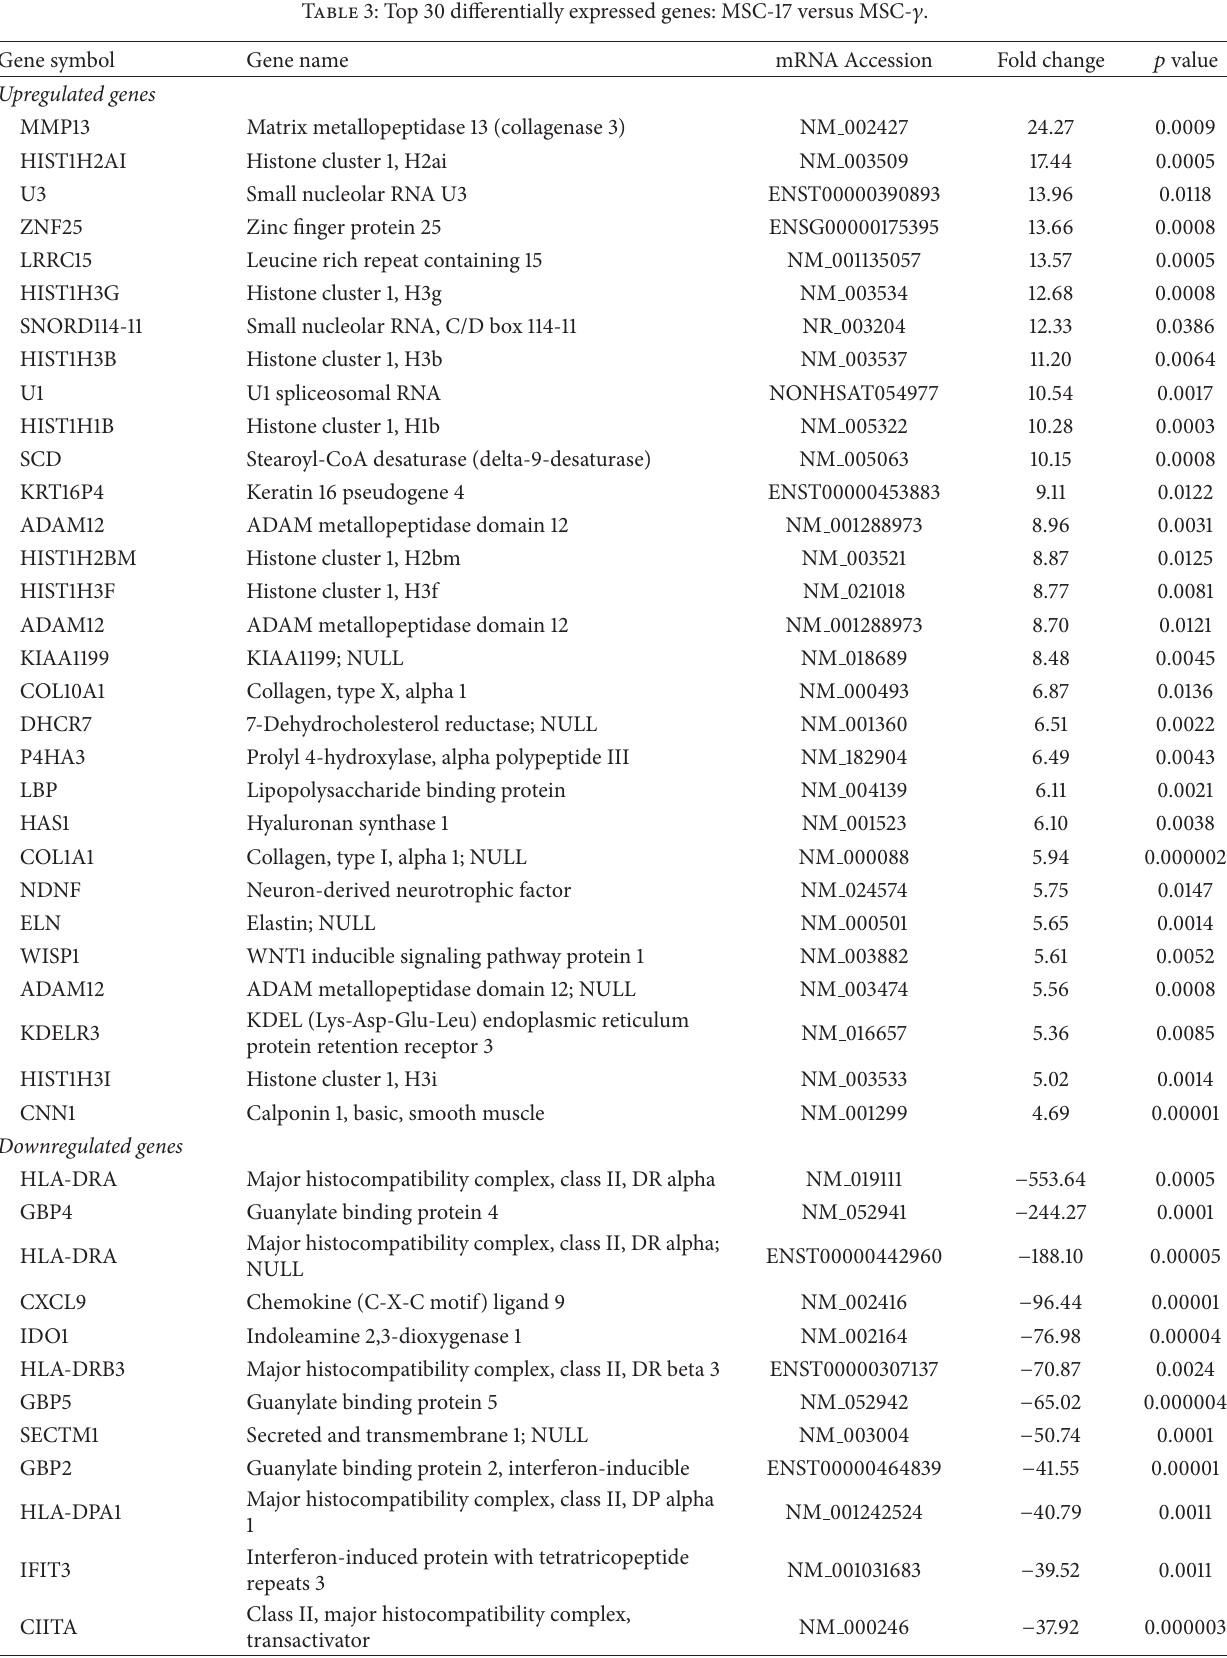
Table 3: Top 30 differentially expressed genes: MSC-17 versus MSC- 𝛾